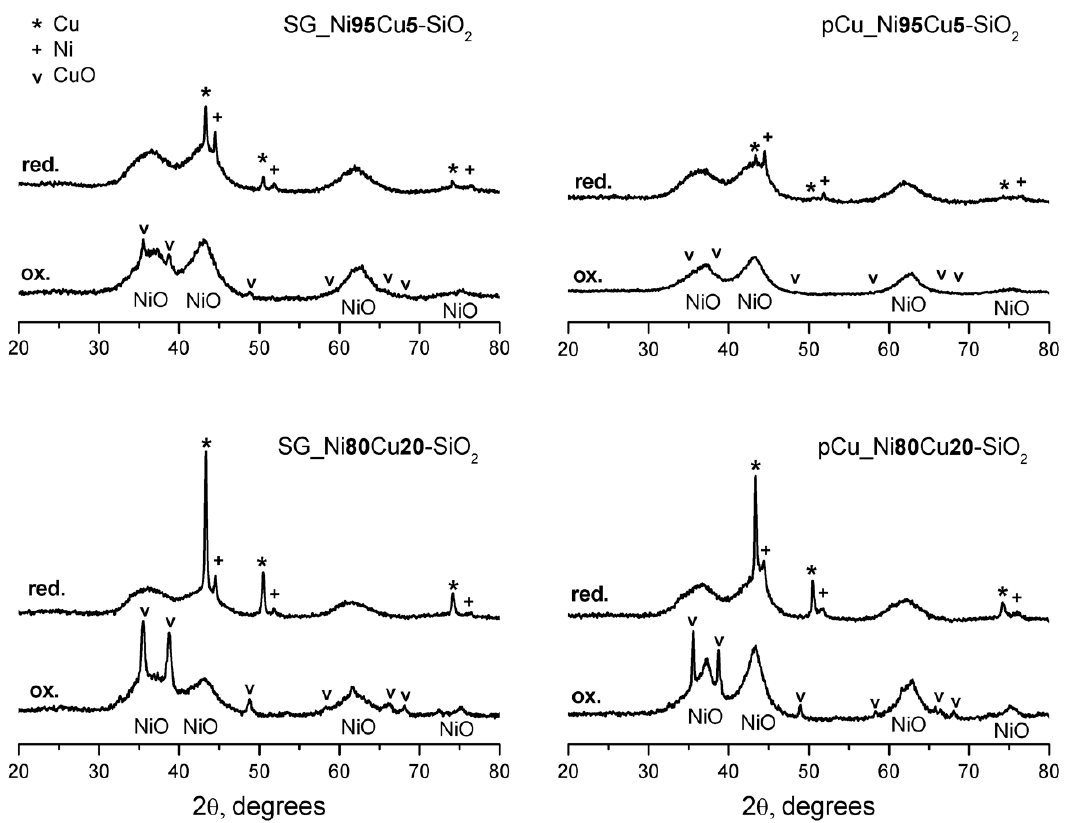
Figure 3. X-ray di ff raction patterns of the catalysts SG_Ni95Cu5-SiO 2 , SG_Ni80Cu20-SiO 2 , Figure 3. X-ray diffraction patterns of the catalysts SG_Ni95Cu5-SiO 2 , SG_Ni80Cu20-SiO 2 , pCu_Ni95Cu5-SiO 2 , and pCu_Ni80Cu20-SiO 2 , before (ox.) and after reduction pCu_Ni95Cu5-SiO 2 , and pCu_Ni80Cu20-SiO 2 , before (ox.) and after reduction (red.).